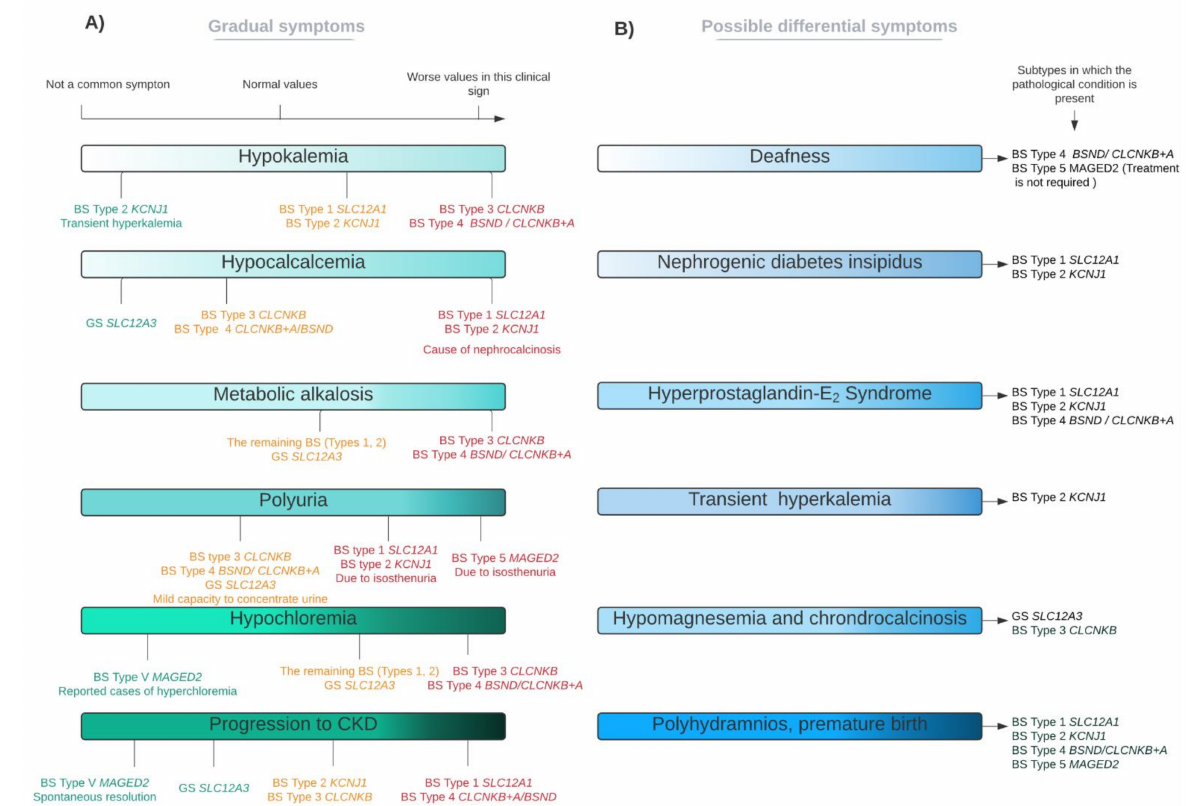
Figure 3. The phenotypic spectrum of GS and BS; principal signs. This figure reflects the high variability that exists among the different subtypes of BS and GS. ( A ) Clinical parameters present in several subtypes, with different levels of severity. Red colour is indicative of a worse severity, whilst orange and green correspond to a lesser disease severity (in this descending order). ( B ) Characteristic (but not necessary) clinical parameters of specific subtypes, which can be used for differential diagnosis (if present). For these cases, there are not differential grades in each